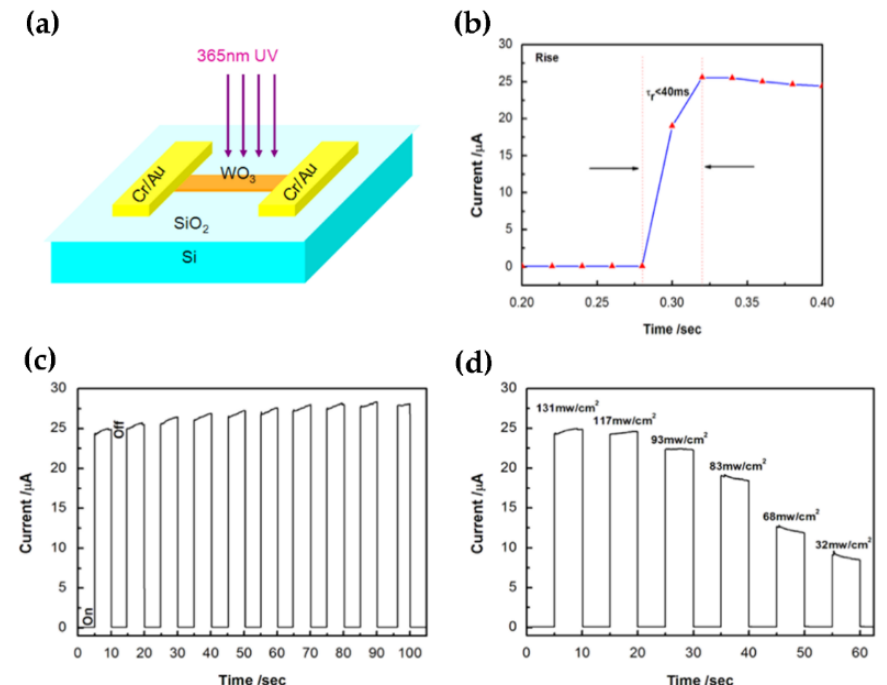
Figure 1. ( a ) Schematic of the device operation. ( b ) The photocurrent responses with time under the illumination of 365 nm. ( c ) The time − resolved photocurrent of the photodetector in response to light on/off at an irradiance of 131 mW/cm 2 with 365 nm light. ( d ) The photocurrent–time curve with the change of light intensity. Reproduced or adapted from [31].